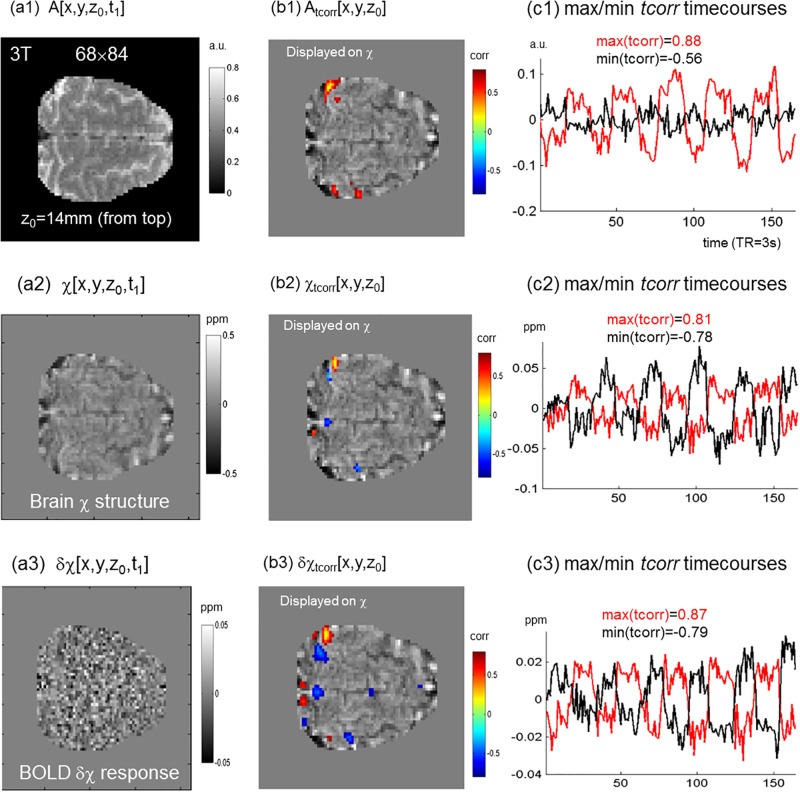
A low-field (3T) and low-resolution (2mm) brain task fMRI experiment (finger tapping) with task function analyses in different dataspaces: (a1,b1,c1) fMRI magnitude, (a2,b2,c2) reconstructed susceptibility (χ), and (a3,b3,c3) reconstructed temporal susceptibility change (δχ).A brain snapshot state (at a timepoint t1) was displayed with an axial slice (z0 = 14mm from brain top) in (a1) magnitude, (a2) reconstructed χ, and (a3) reconstructed δχ. Correspondingly, task correlation fmap’s were displayed in (b1,b2,b3); and the maximal (red) and minimal (black) task-correlated voxel timecourses were plotted in (c1,c2,c3). Note that the functional tcorr maps (b1,b2,b3) were displayed over the reconstructed brain χ image (a2). Display units: a.u., arbitrary unit (dimensionless); corr, correlation value in range [–1, 1] (dimensionless); ppm, parts per million 10−6 (dimensionless).